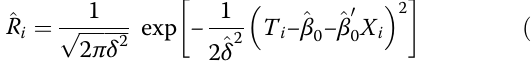
Table 2 District disaggregated Prosopis invasion level and household per capita consumption expenditure Average fractional cover of Prosopis